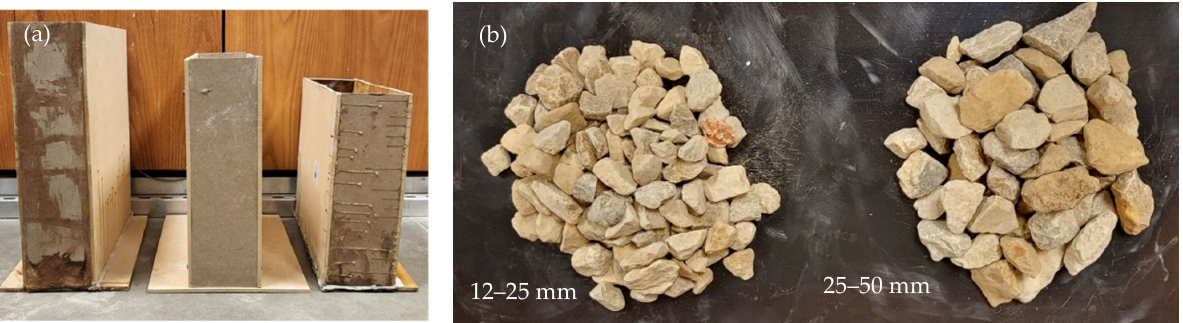
Figure 3. Experimental setup for ( a ) testing varying depth, with ( b ) two different types of aggregates of sizes 12–25 mm and 25–50 mm.